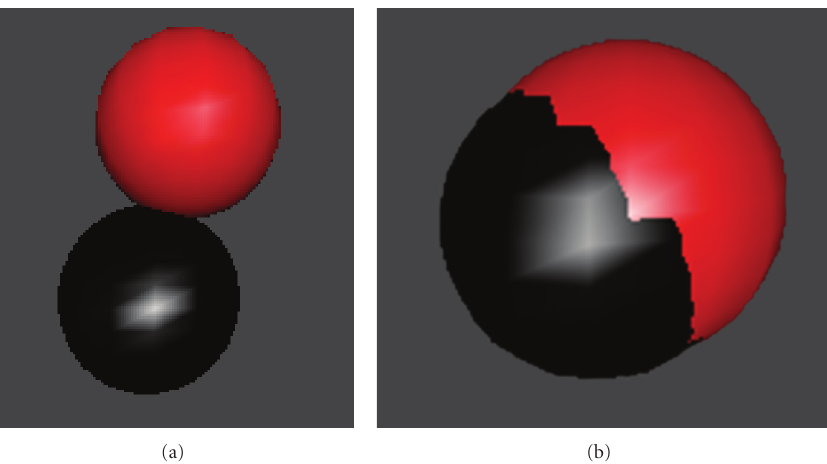
Figure 3: Results of bootstrapped PCA examining di ff erences between ethogram data collectedby two biologists for the group of otters over one day. Black = RLW, red = CK. Cumulative proportionof variance explained by first 3 principal components > 0 . 999. (b) as above but with playing and swimming combined.